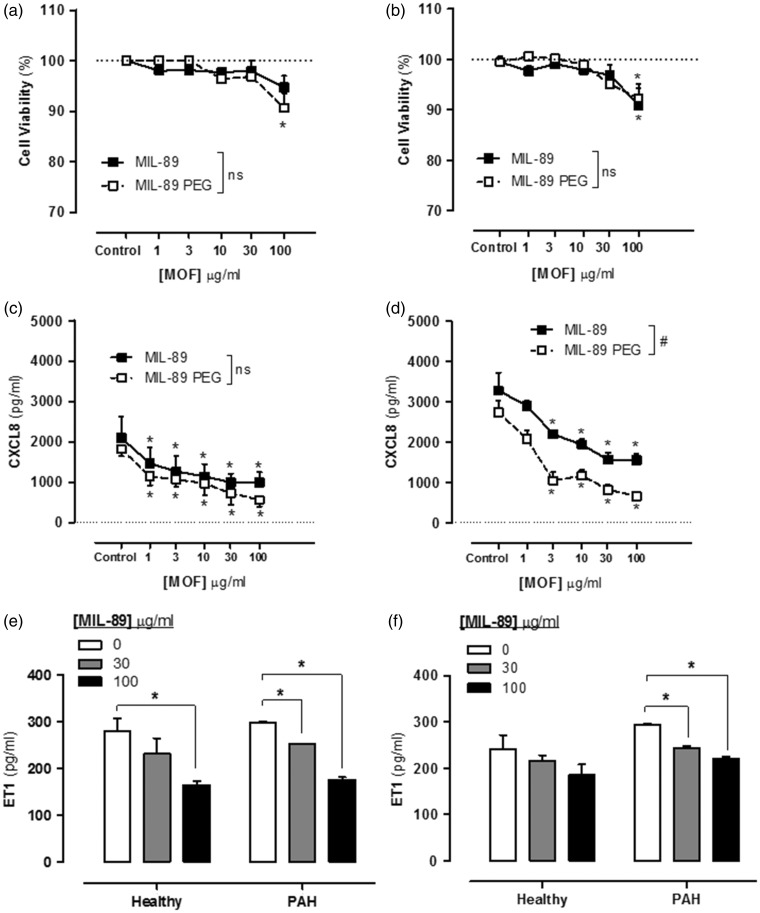
Effect of MIL-89 and MIL-89 PEG on endothelial cell viability (a, b), release of CXCL8 (c, d) and endothelin (ET)-1 (e, f). (a, c) Data from control donors (n = 6, three donors) and (b, d) from donors with PAH (n = 6 from three donors). Data are the mean ± SEM; cells were treated for 24 h. (a–d) Statistical analysis for effects between each MOF was determined by two-way ANOVA (#P < 0.05) and for each MOF compared to the relevant controls by one-way ANOVA followed by Dunnett’s Multiple Comparison Tests (*P < 0.05). (e, f) Data were analyzed using two-way ANOVA followed by Bonferroni post-tests (*P < 0.05).